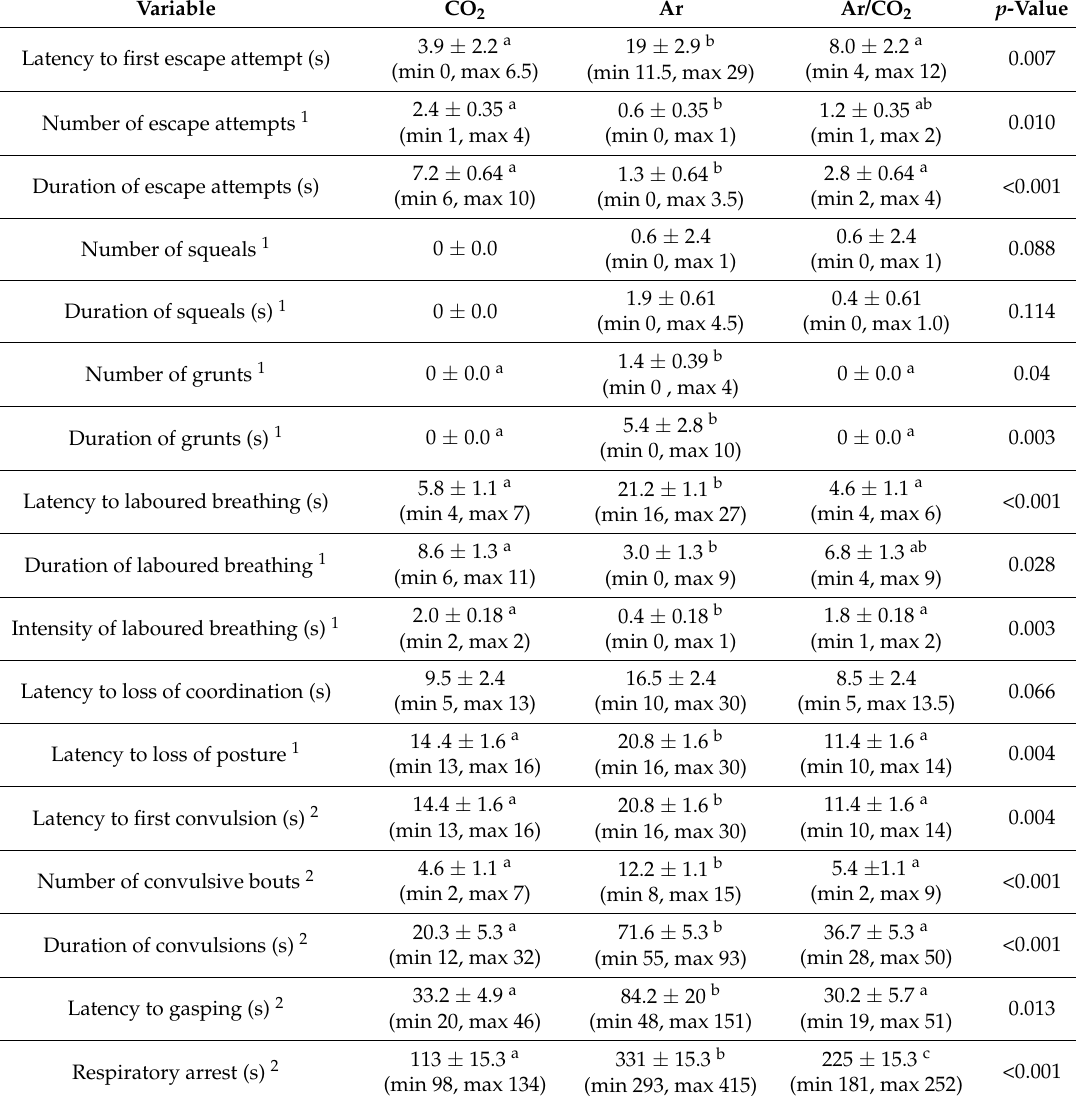
Table 2. Treatment least squares means ( ± SEM) for piglet behaviour during euthanasia with